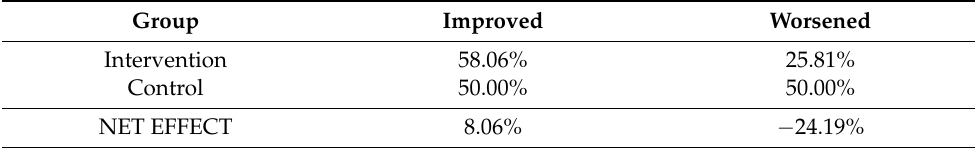
Table 5. Improvement or worsening in children’s anxiety symptomatology (in